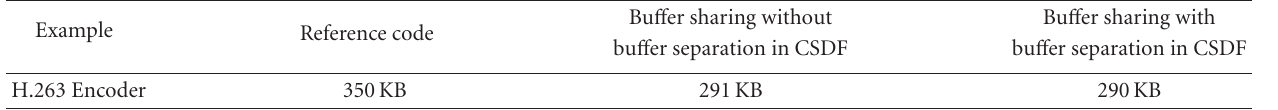
Table 2: Comparison of synthesize codes with reference code for the H.263 encoder.